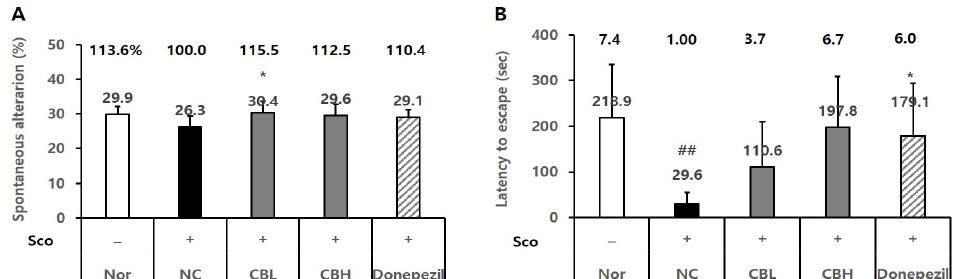
Figure 5. Learning and memory improving effect of CB extract in chronically scopolamine-treated rats in ( A ) Y-maze test and ( B ) passive avoidance test (PAT). Rats were randomly divided into five groups. Nor, normal, commercial diet + saline; NC, negative control (Sco), commercial diet + Sco in saline; CBL; CB extract 0.07% diet + Sco in saline; CBH, CB extract 0.14% diet + Sco in saline; Donepezil; commercial diet + 1 mg/kg Donepezil in saline + Sco in saline (n = 8 for Y-maze test and PAT). Sco at 1 mg/kg was administered to rats one time per day for 21 days (i.p). Significance was determined by one-way ANOVA with post hoc Tukey’s multiple comparison test; Data are presented as means ± standard errors of the mean (SEM). ## p < 0.01, significance compared with the control (white bar). * p < 0.05 significance compared with Sco ‐ treated groups (black bar).